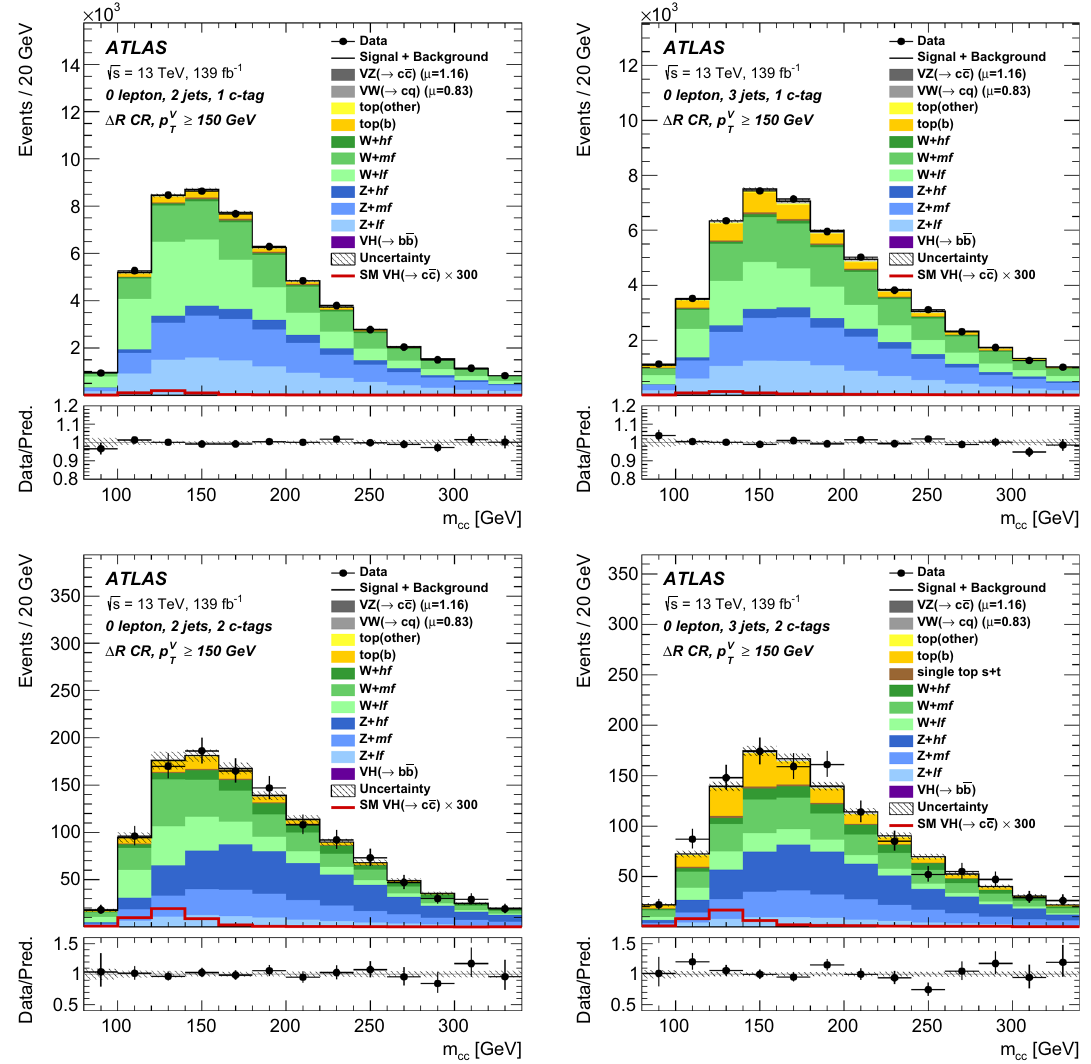
Fig. 11 Post-fit distributions of the four 0-lepton high- (cid:11) R control regions. The total signal-plus-background prediction is shown by the solid black line and includes the H → c ¯ c signal scaled to the best- fit value of μ VH ( c ¯ c ) = − 9. The H → c ¯ c signal is also shown as an